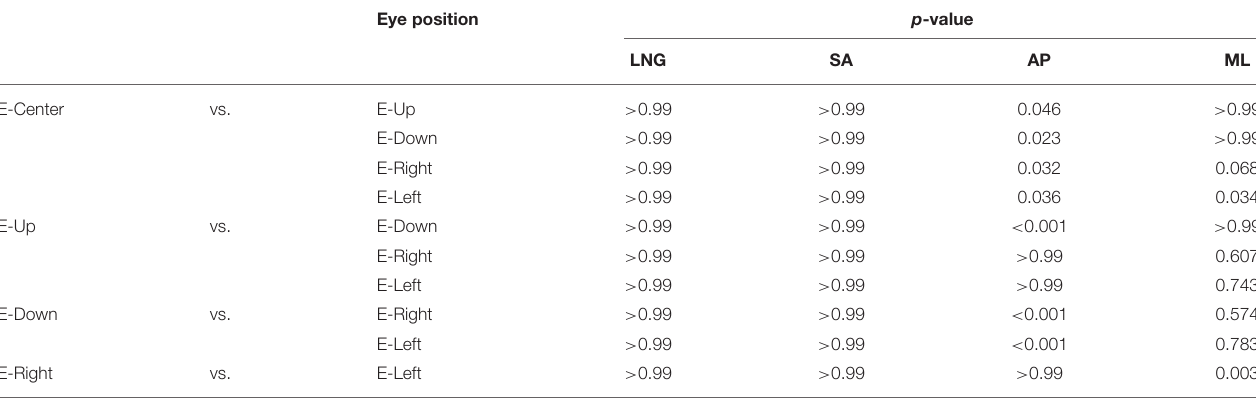
TABLE 2 | Results of post-hoc